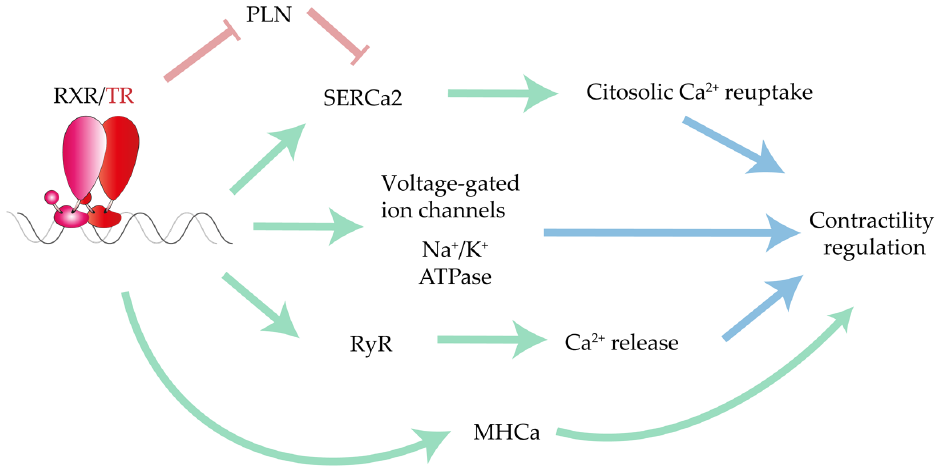
Figure 6. TR signaling in cardiomyocyte contractility. Schematic representation of TR/RXR functioning during cardiac contraction. Blue arrows denote homeostatic regulation. Green arrows denote induction. Red arrows denote inhibition. RXR, retinoid X receptor. TR, thyroid hormone receptor. SERCa2, Sarcoplasmic/Endoplasmic Reticulum Calcium ATPase. PLN, Phospholamban. RyR, Ryanodine Receptor.